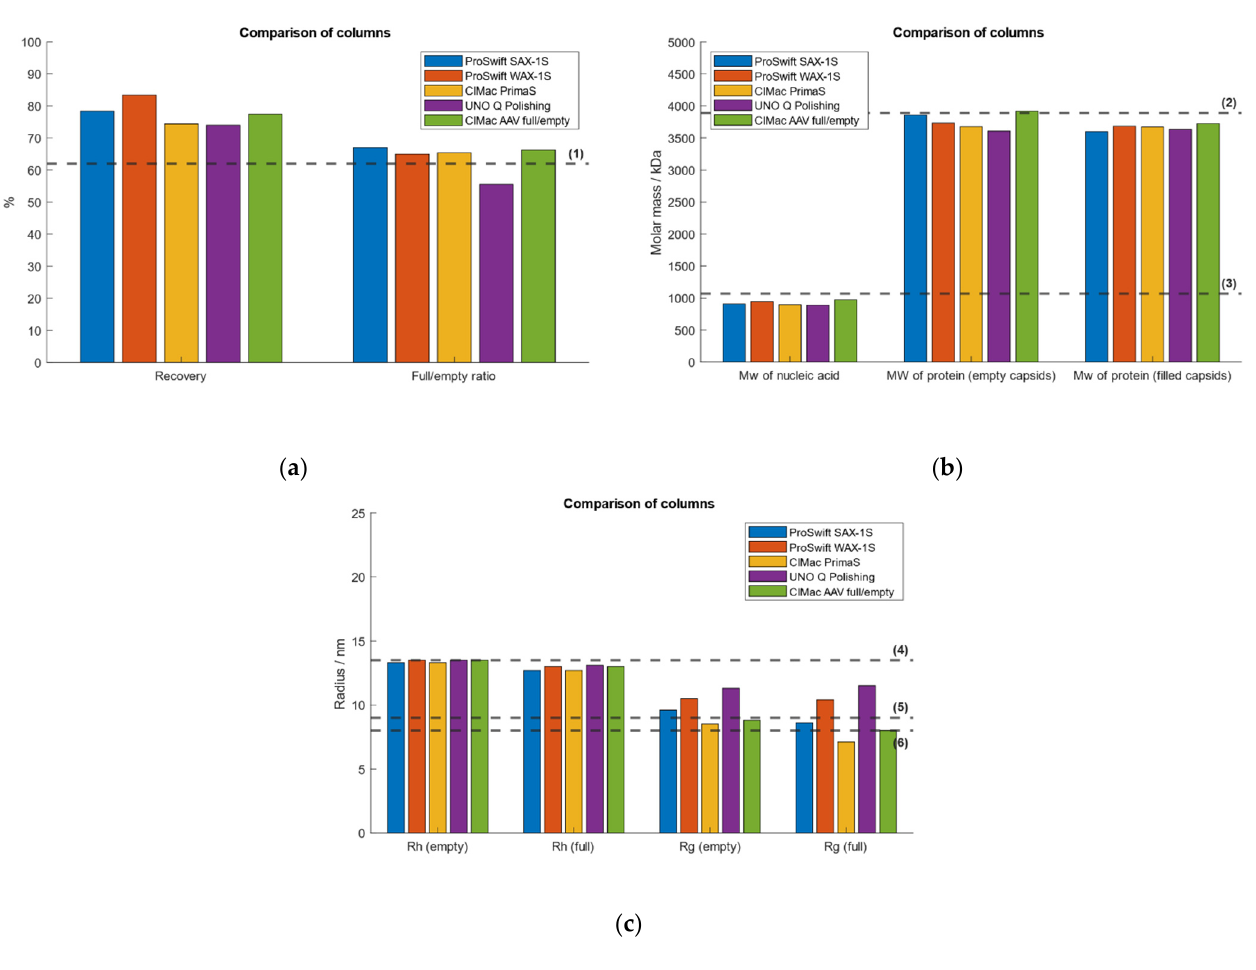
10 of 15 Figure 5. Overlay of the LS chromatograms (solid lines) and molar masses of the total capsid, protein and transgene (dashed lines) of serotypes AAV5 (green), AAV6 (pink) and AAV8 (blue).